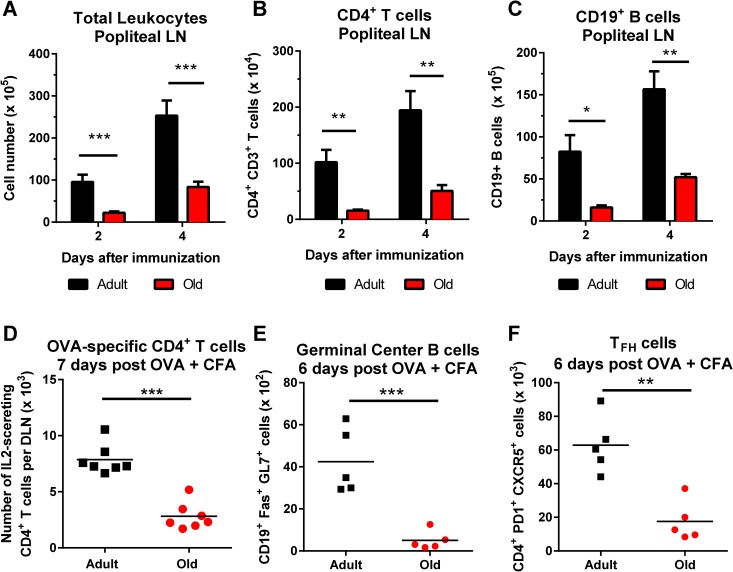
Decreased accumulation of CD4+ T cells and CD19+ B cells in DLN of old mice after immunization with ovalbumin.
A-C. Adult and old mice were immunized with ovalbumin (OVA) complexed with complete Freund’s adjuvant in the footpad. At the indicated days post infection, the draining popliteal LN was harvested, and cells were counted (A). Antibody staining detected specific lymphocyte populations including CD4+ T cells (B) and CD19+ B cells (C). The results were pooled from two independent experiments with a total of 5 mice per group and data is expressed as the mean ± the standard error of the mean (SEM). D. Numbers of IL-2 secreting CD4+ T cells as judged by ELISPOT assay following OVA323–337 peptide stimulation in the DLN of adult and old mice at day 7 after immunization. E-F. Draining popliteal LN cells were analyzed by flow cytometry at 6 days after infection, and the numbers of GC B cells (CD19+ Fas+ GL7+) (E) and TFH cells (CD4+ PD1+ CXCR5+) (F) were quantified. Each data point represents and individual mice and the results are pooled from two independent experiments. Asterisks indicate statistical significance (*, P < 0.05; **, P < 0.01; ***, P < 0.001; unpaired t test).